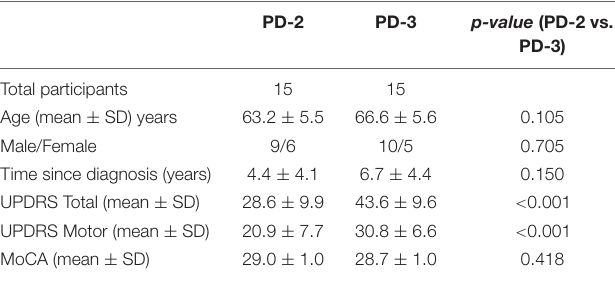
TABLE 1 | Demographic and clinical data by Hoehn and Yahr stage (stage 2: PD-2; stage 3: